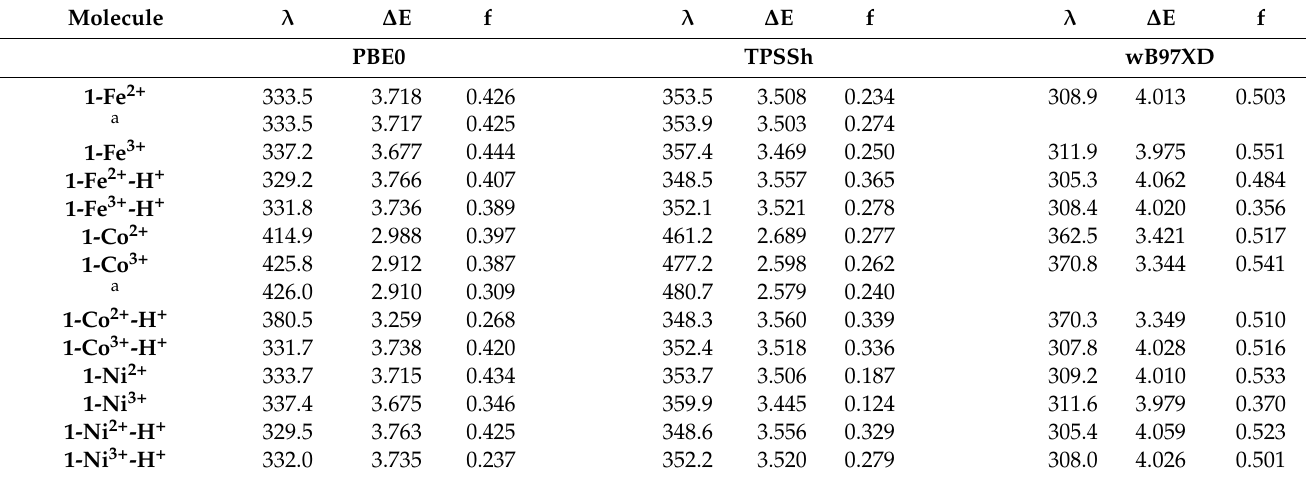
Table 4. Main absorption peaks, λ (nm), energy differences, ∆ E (eV), and f-values of the 1-M 2+ , 1-M 3+